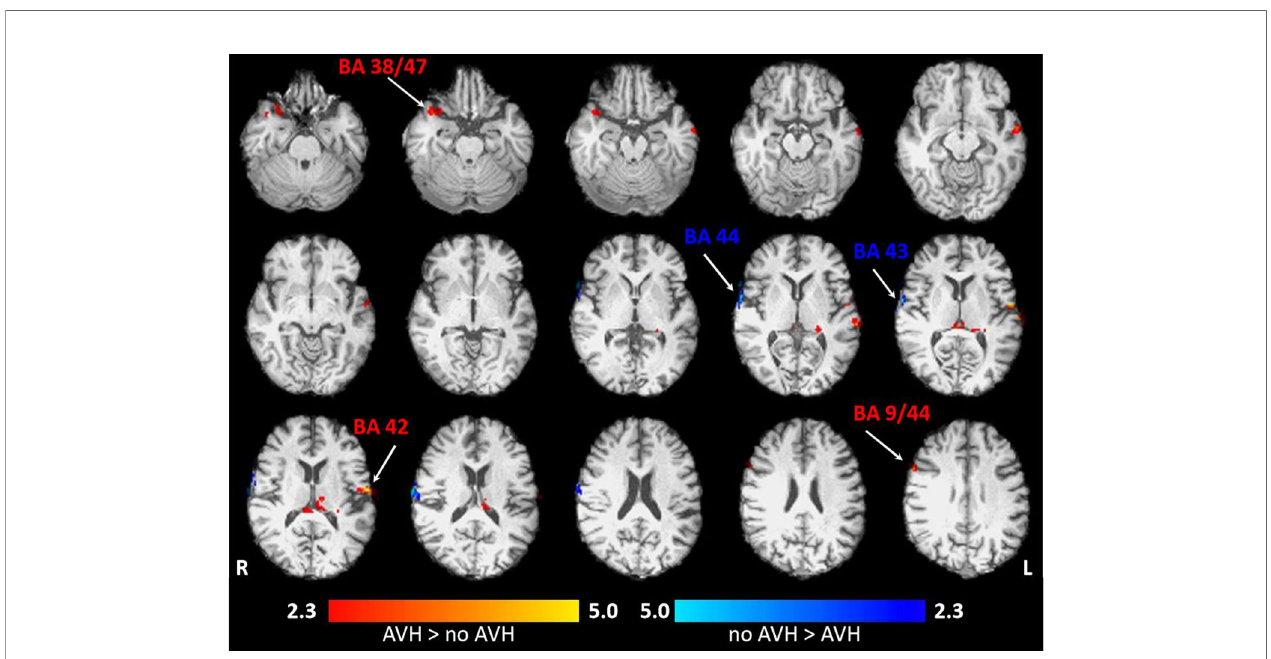
FIGURE 3 | Localization and strength of brain activation during acoustic stimulation in Mr. WF. Axial view (superior view) is opposed to the observer's view: the left side of the brain corresponds to the right side. The red-colored clusters re fl ect the brain activation during auditory-verbal hallucination (AVH) > no AVH. The blue-